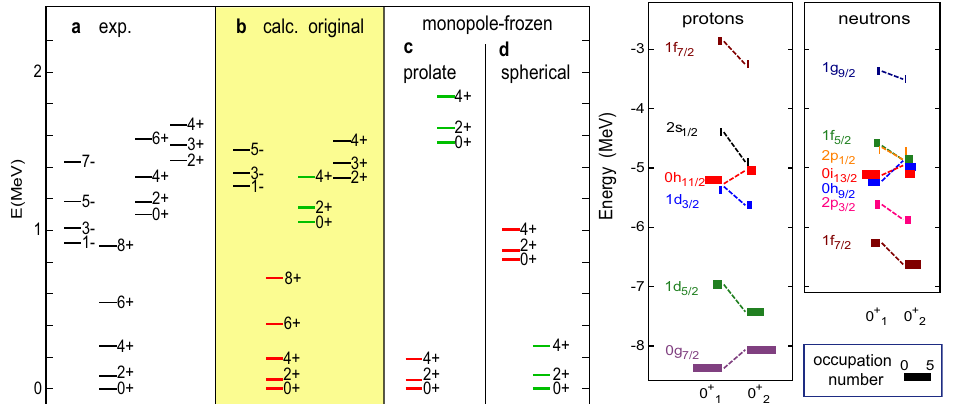
Figure 13. Left : ( a ) Experimental energy levels [42], ( b ) calculated original energy levels and ( c , d ) monopole-frozen energy levels of 154 Sm. Right : ESPE (vertical position) and occupation number (horizontal width). Taken from Figures 2 and 3 of